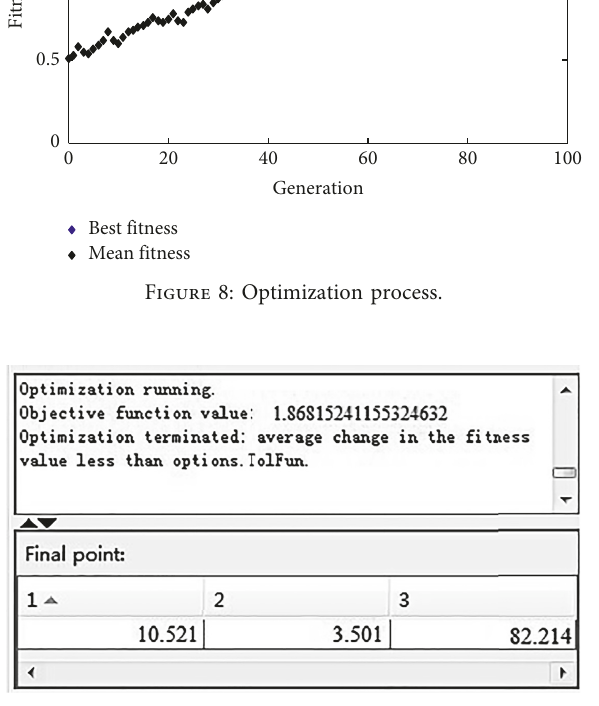
Figure 9: Optimization results of multiple objective. Table 2: Comparison of optimization parameters and original parameters.